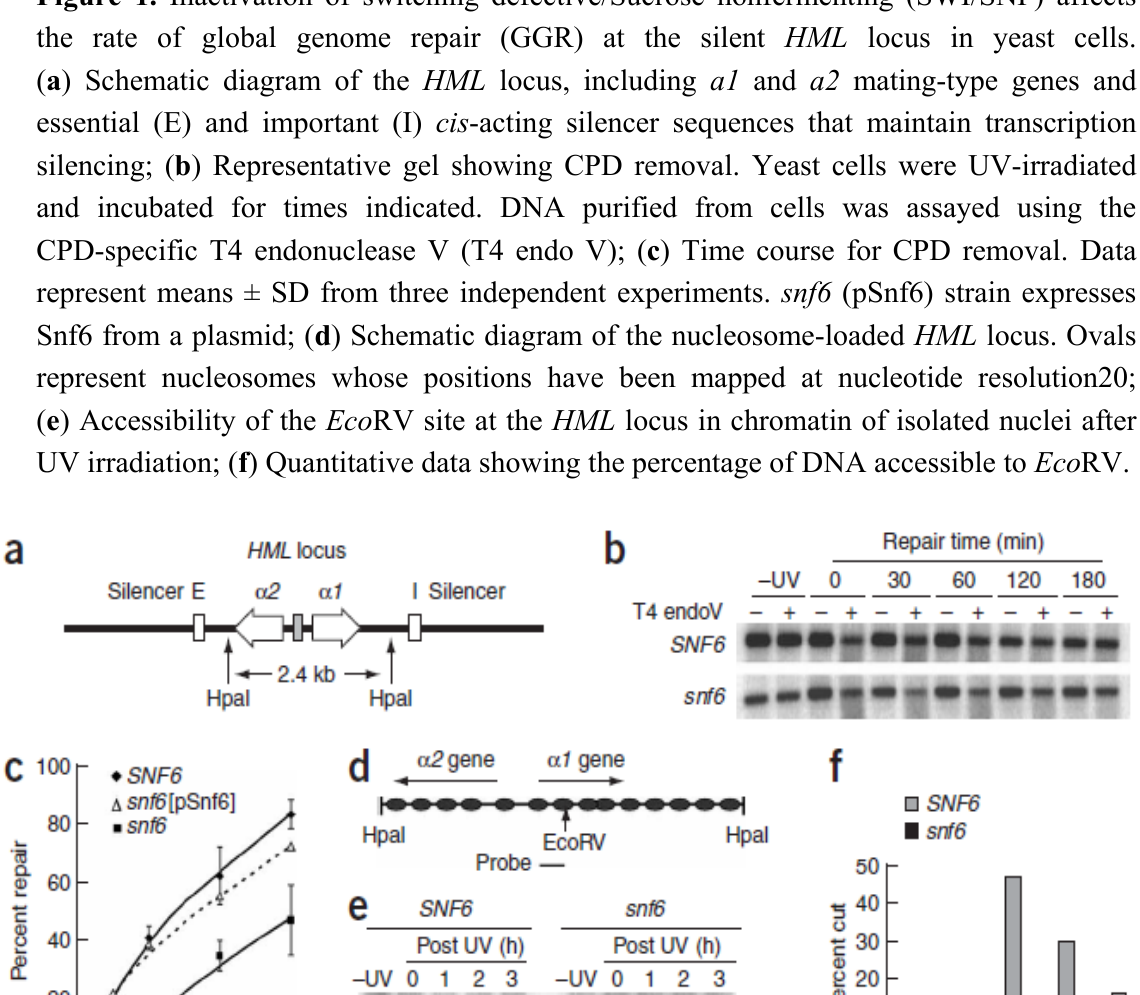
Figure 1. Inactivation of switching defective/Sucrose nonfermenting (SWI/SNF) affects the rate of global genome repair (GGR) at the silent HML locus in yeast